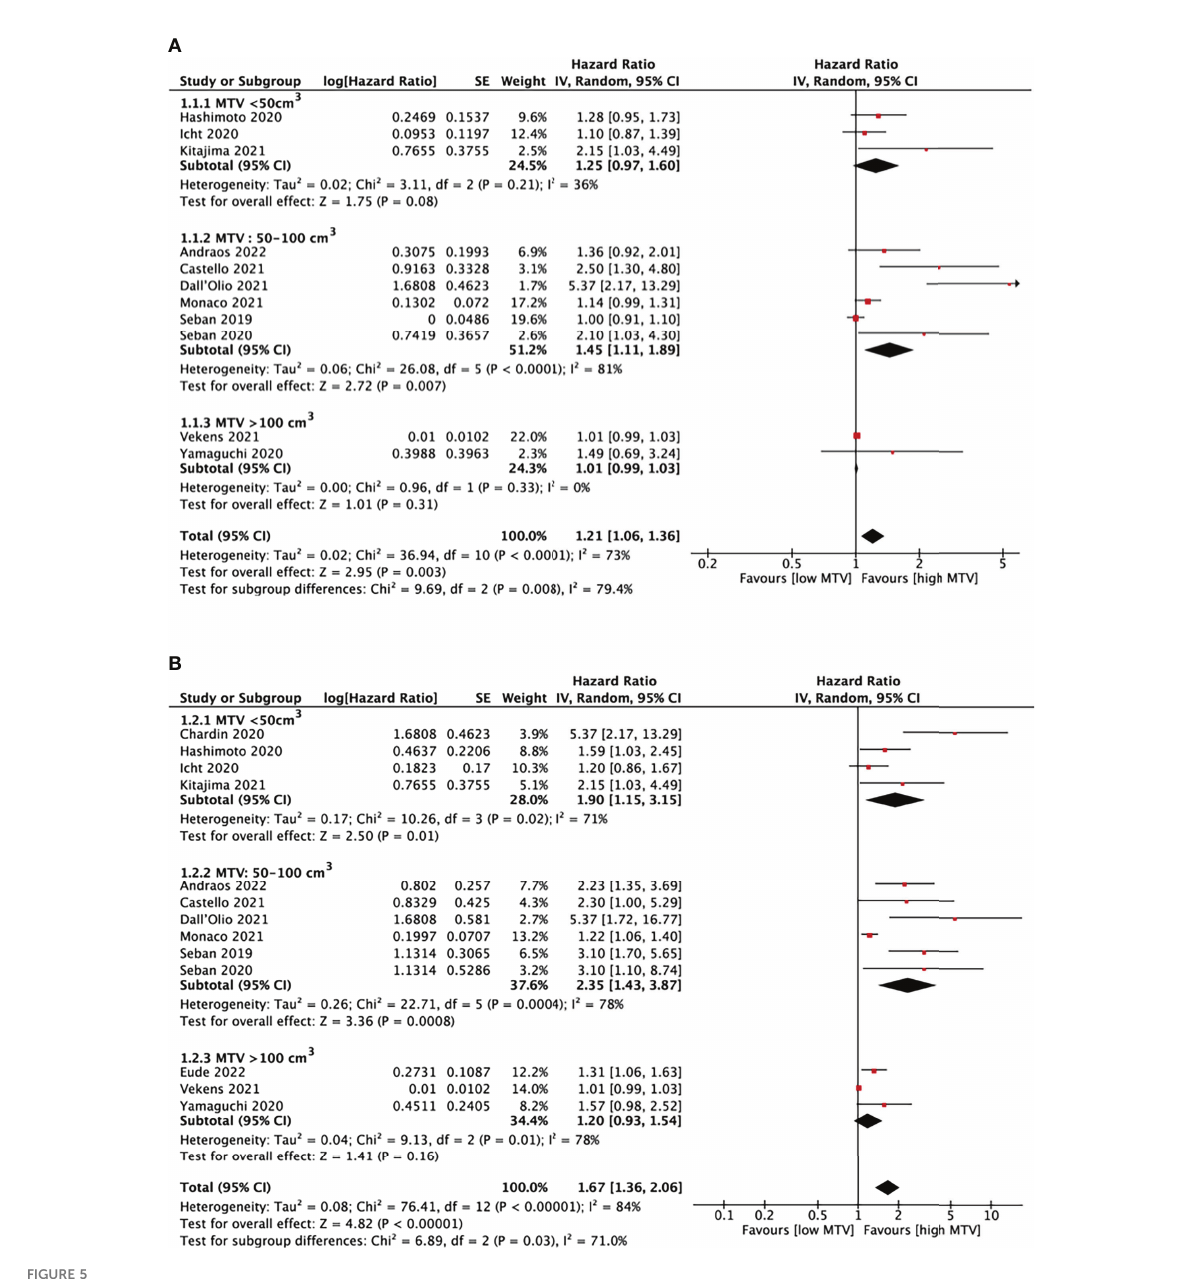
FIGURE 5 Forest plots of hazard ratios comparing progression free survival (A) or overall survival (B) of patients with high level versus low level metabolic tumor volume treating with immune checkpoint